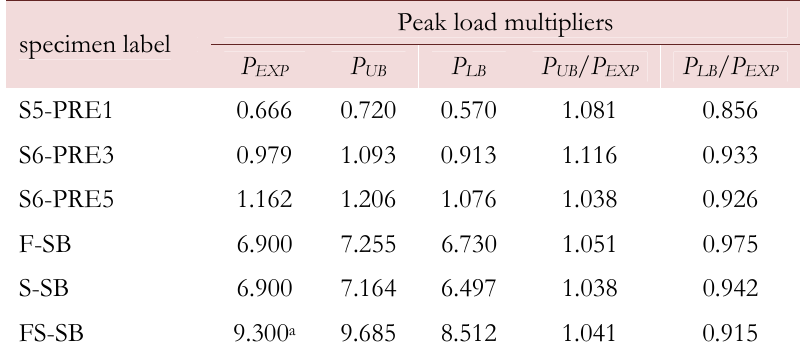
Table 6: Peak load multipliers for the analysed specimens